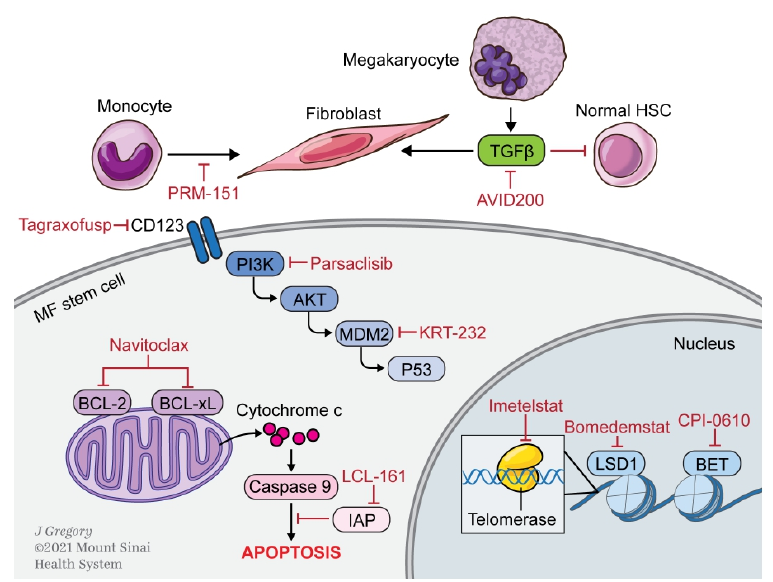
Figure 1. Targets of novel therapeutics in myelofibrosis for agents in clinical development. Multiple pathways are targeted by the next generation of agents for myelofibrosis, including apoptosis, epigenetics, telomerase, and numerous intracellular signaling pathways.